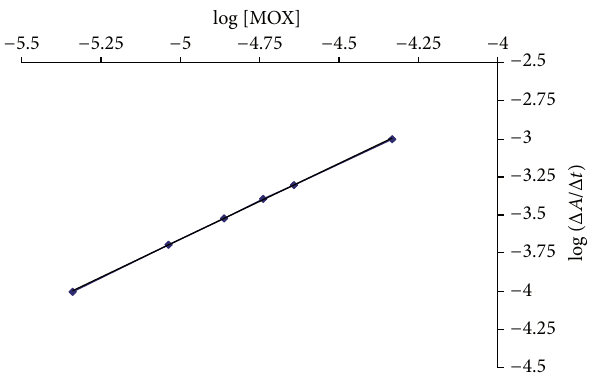
Figure 8: Calibration plot of logarithm rate of the reaction against logarithm molar concentration of MOX for rate data method.